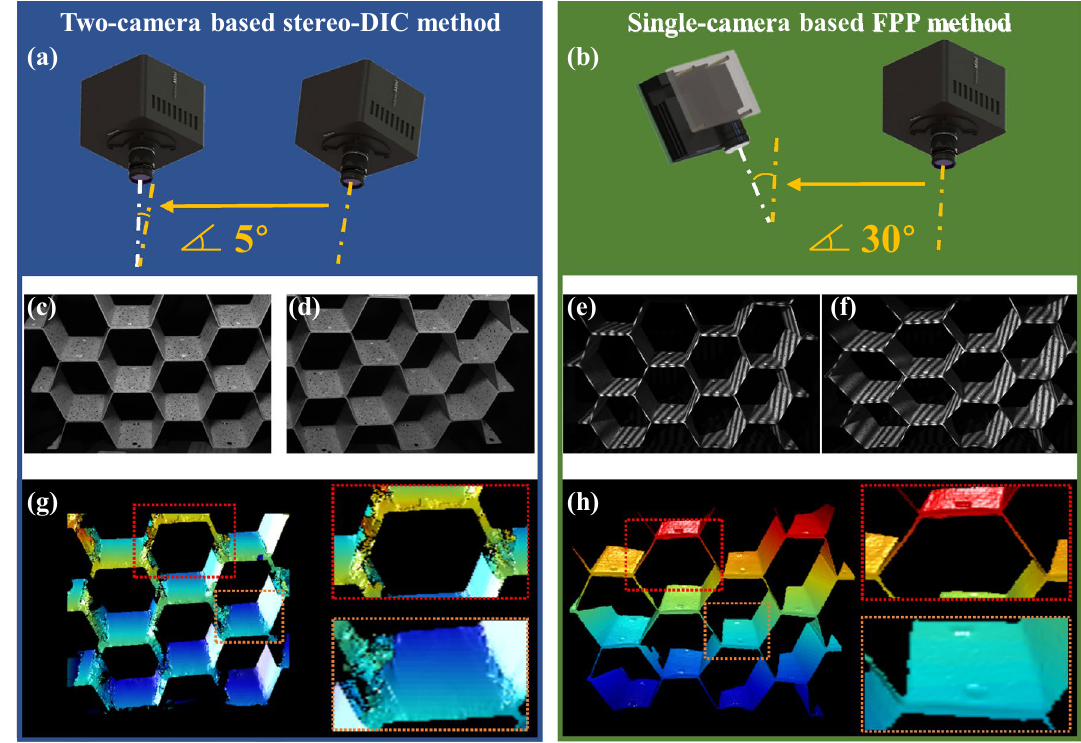
Figure 6. Comparative experiment on reconstruction of a complex honeycomb structure using stereo-DIC and FPP. ( a ) Measuring equipment of two-camera based stereo-DIC method. ( b ) Measuring equipment of single- camera based FPP method. ( c , d ) Captured images from left and right cameras in stereo-DIC. ( e , f ) Captured fringe patterns at two moments in FPP. ( g ) Reconstructed disparity map in stereo-DIC. ( h ) Reconstructed depth map in FPP.